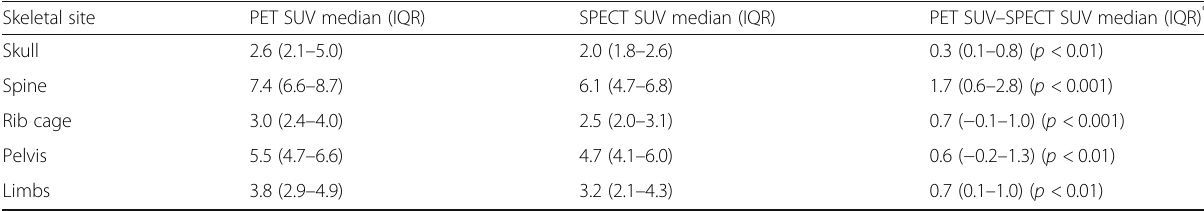
Table 3 SUVs mean,bg from normal appearing bone at different skeletal sites Skeletal